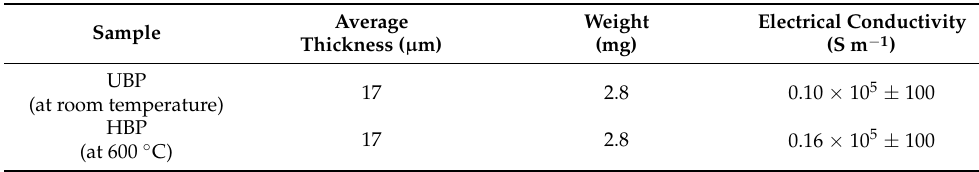
Table 1. Characteristics of UBP and HBP